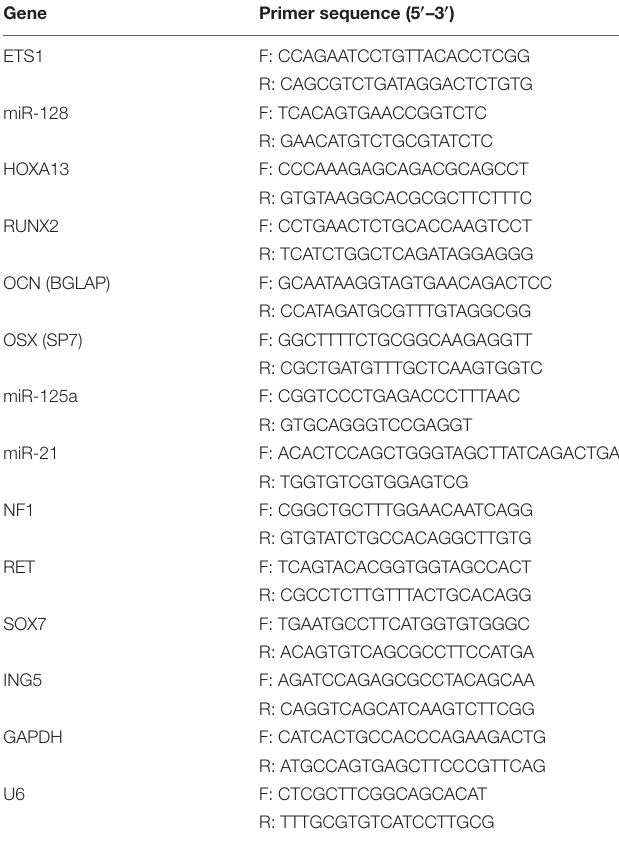
TABLE 1 | Primer sequences for